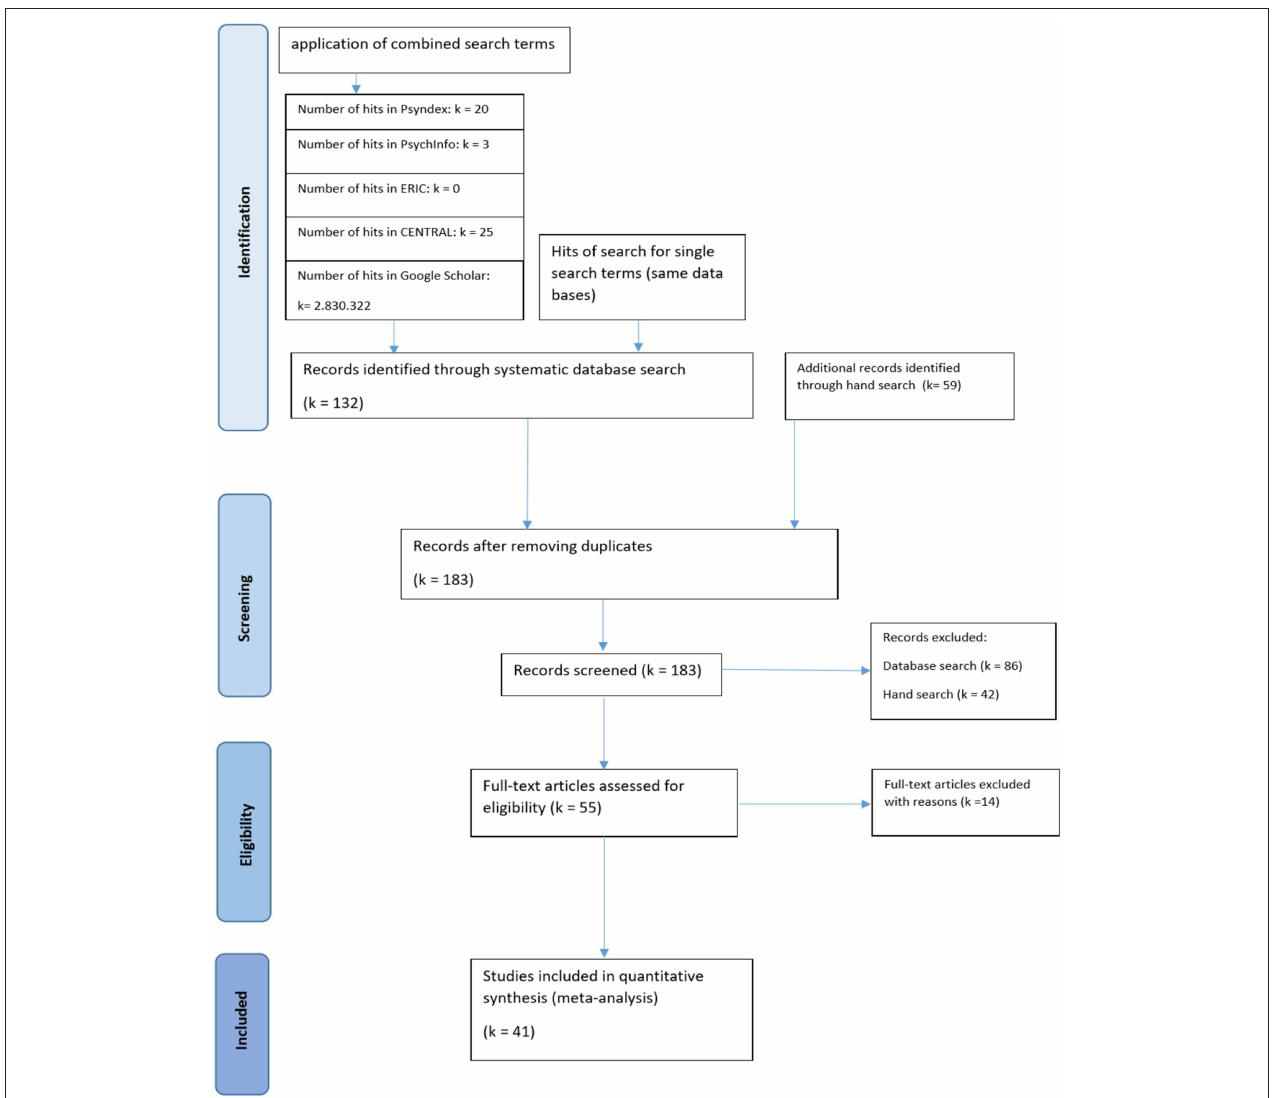
FIGURE 1 | Flowchart of selection procedure. Included studies are displayed in the study characteristics overview ( Table 1